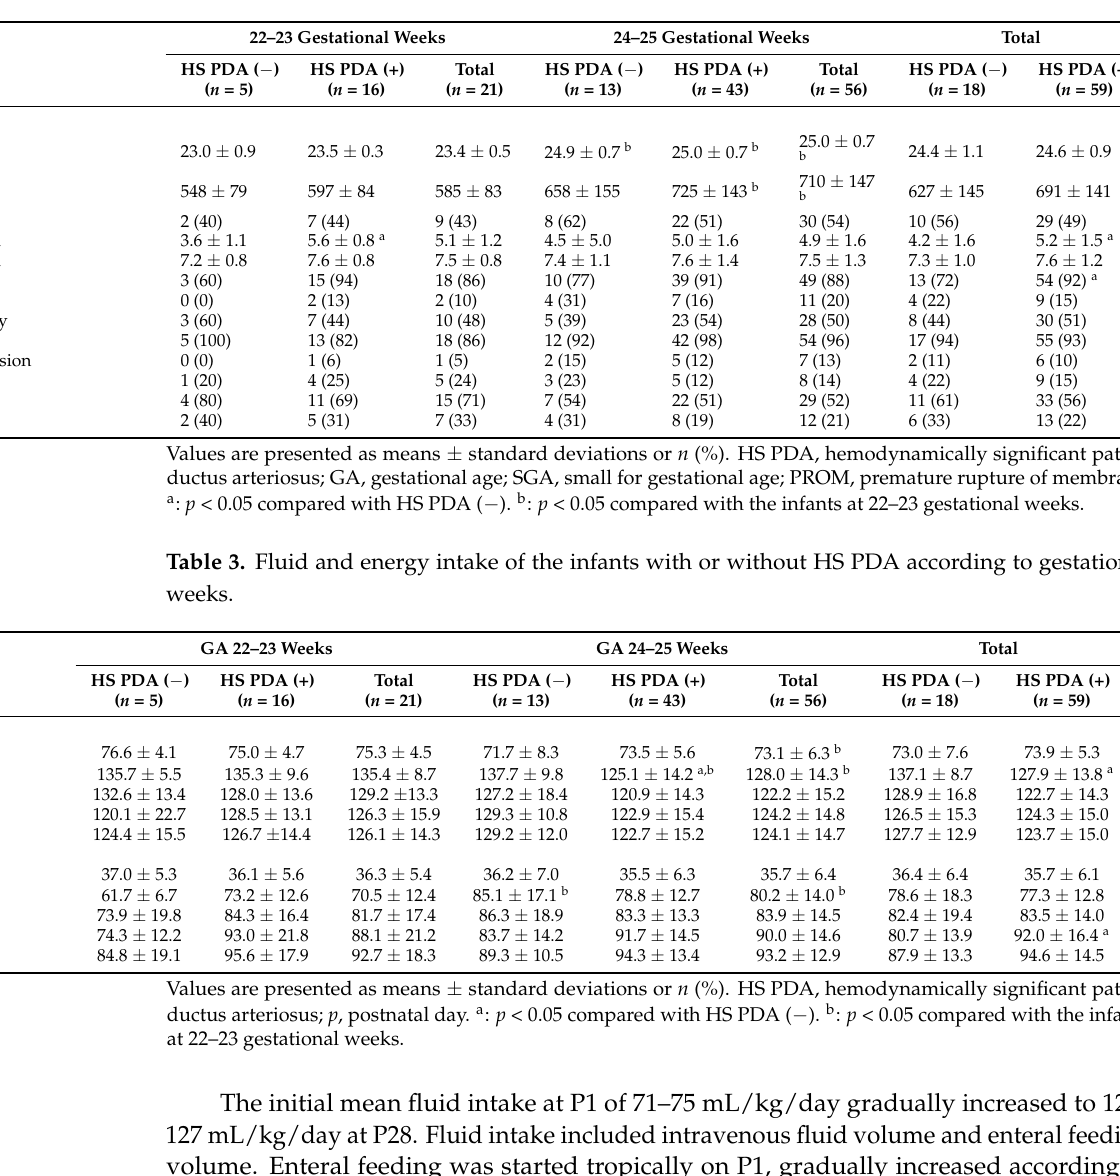
Table 2. Clinical characteristics of the infants with or without HS PDA according to gestational weeks.